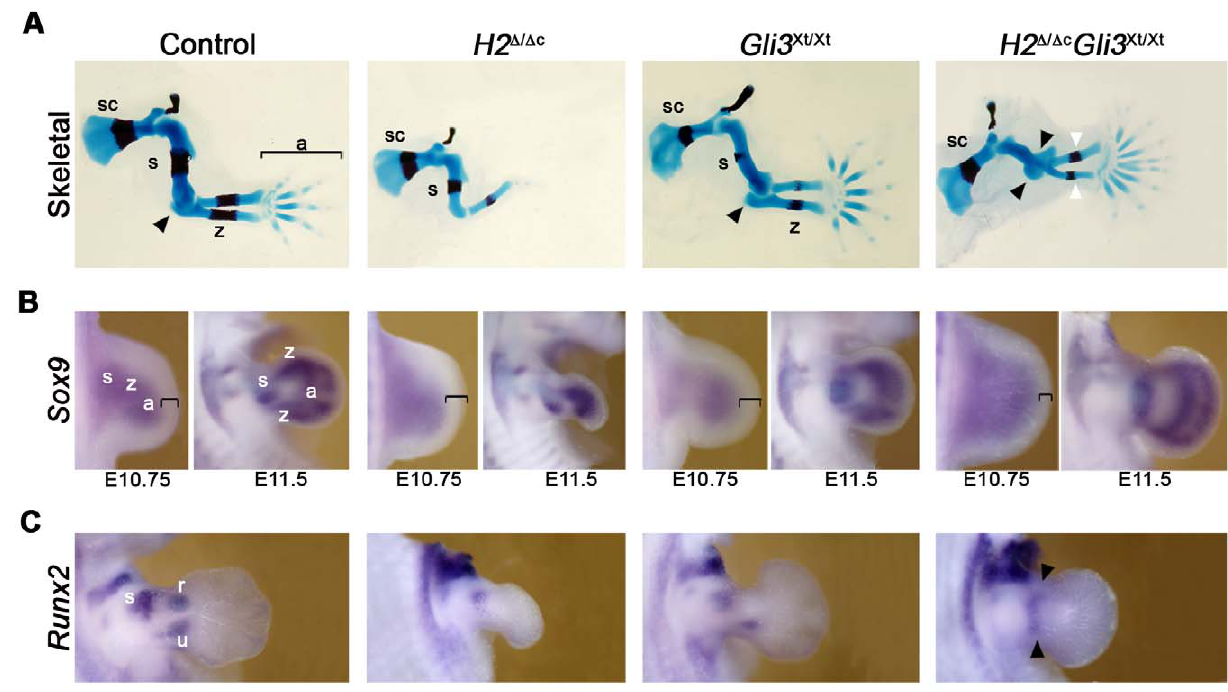
Figure 5. Forelimb buds lacking Hand2 and Gli3 lack AP polarity along the entire PD axis. (A) Skeletal preparations of H2 D / D c Gli3 Xt/Xt , H2 D / D c , and Gli3 Xt/Xt single mutant and control ( H2 D ./ ) forelimbs at E14.5. The black arrowheads point to the duplicated elbow-like structure while the white arrowheads point to the symmetrical zeugopodal skeletal elements in H2 D / D c Gli3 Xt/Xt limbs. Note the shortening of the stylopod in double mutant limbs. (B) Expression of Sox9 in limb buds at E10.75 (38 somites) and E11.5. Black brackets indicate the non-expressing distal mesenchyme that is reduced in H2 D / D c Gli3 Xt/Xt limb buds. (C) Runx2 expression in wild-type limb buds marks the presumptive stylopod (s) and zeugopodal domains (r/u) at E12.0. Note that establishment of anterior expression domain is delayed in Gli3 Xt/Xt mutant limbs as it becomes visible by E12.5 (data not shown). Black arrowheads point to the apolar proximal expression of Runx2 in H2 D / D c Gli3 Xt/Xt mutant limb buds. In wild-type limb buds, the presumptive expression domains for Sox9 and Runx2 are indicated as previously defined [42,63]. sc: scapula; s: stylopod; z: zeugopod; a: autopod; u: ulna; r: radius. All limb buds are oriented with the anterior to the top and the posterior to the bottom.